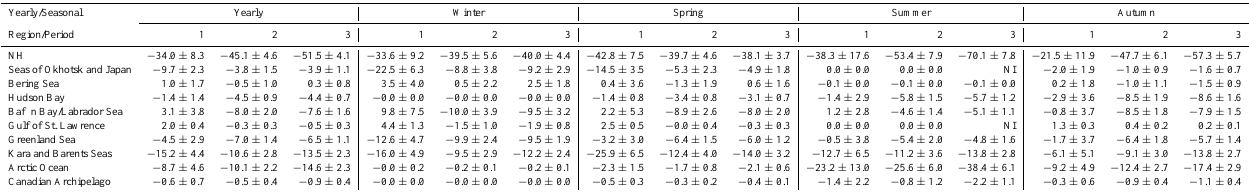
Table 3. Yearly and seasonal Arctic sea ice extent trends with estimated standard deviations (10 3 km 2 yr − 1 ) for each of three periods: 1979– 1996 (1), 1979–2006 (2), and 1979–2010 (3). NI means no ice. Values for 1979–1996 are from Parkinson et al. (1999); values for 1979–2006 are from Parkinson and Cavalieri (2008); and values for 1979–2010 are from Table 1 above. Yearly/Seasonal Yearly Winter Spring Summer Autumn Region/Period